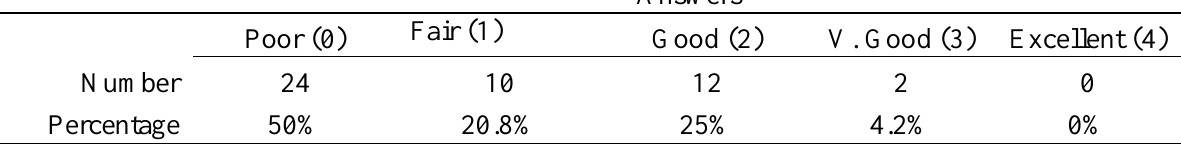
Table 3 . Distribution of Parents’ Answers to the Global Question: How would you rate the health of your child’s teeth, lips, jaws, and mouth?